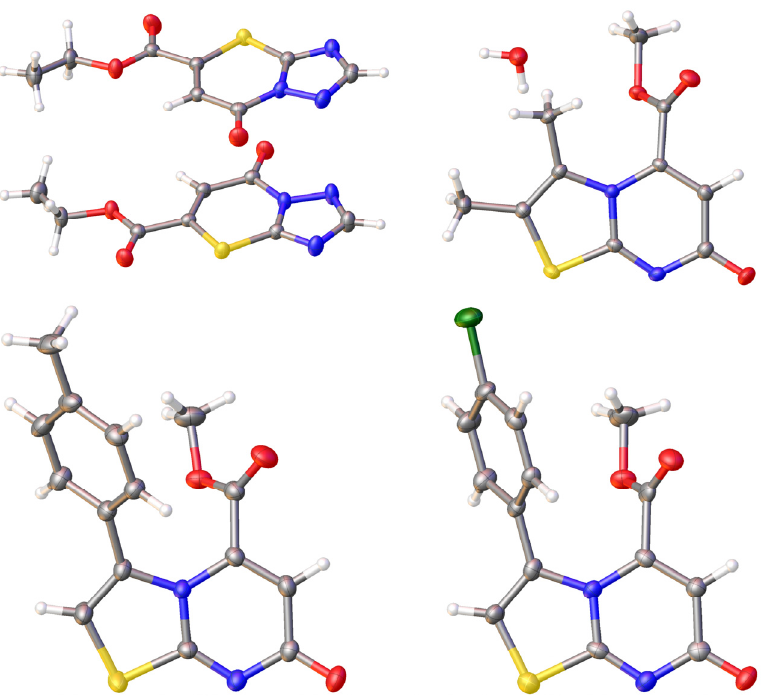
Figure 3. Single-crystal X-ray structure (ORTEP diagrams) of 8 ( top left ), 13a ( top right ), 13b ( bottom left ) and 13d ( bottom right ). Carbon atoms are shown as gray spheres, nitrogen atoms as blue spheres, oxygen atoms as red spheres, sulfur atoms as yellow spheres, chlorine atoms as green spheres and hydrogen atoms as white spheres.